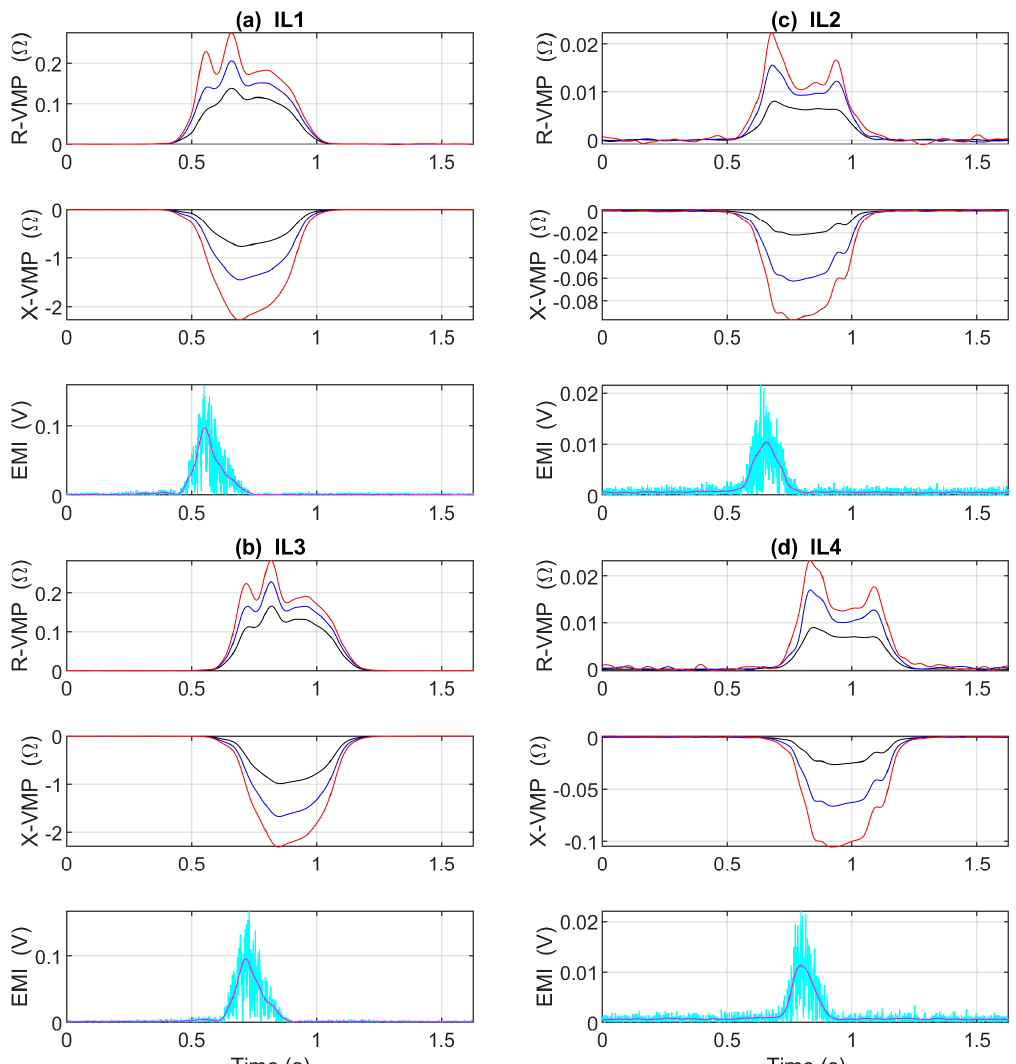
Figure 2. Exemplary VMPs and EMIs of Hyundai ix35 presented as a function of time. R-VMP and X-VMP denote the real and the imaginary impedance components, EMI denotes the electromagnetic interference; ( a ) the first standard IL1 sensor; ( b ) the second standard IL3 sensor; ( c ) the first slim IL2 sensor; and ( d ) the second slim IL4 sensor; red VMPs are obtained at a high frequency component; blue VMPs are obtained at an intermediate value of the frequency component; black at the lowest frequency component, according to the operating frequencies listed in Table 1. The cyan EMI signal is the absolute voltage, the magenta is the average of the low-pass filter output.